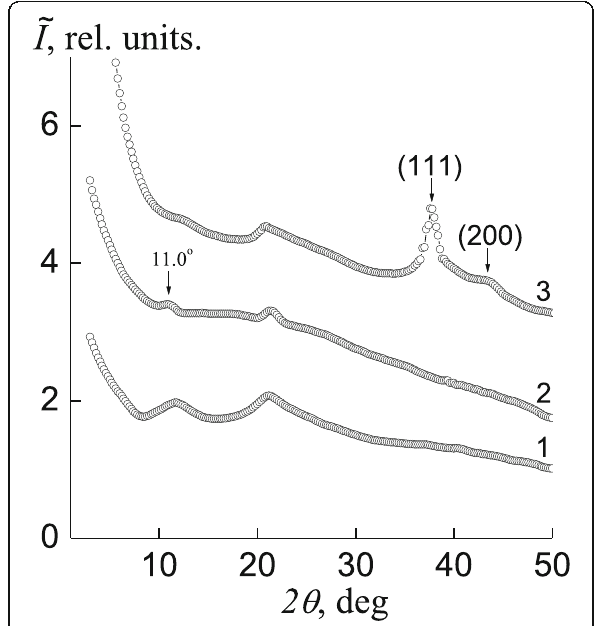
Fig. 2 WAXS patterns of 1 the IPEC pectin – P4VP, 2 the IMC pectin – Ag + – P4VP, and 3 the IPEC – Ag 0